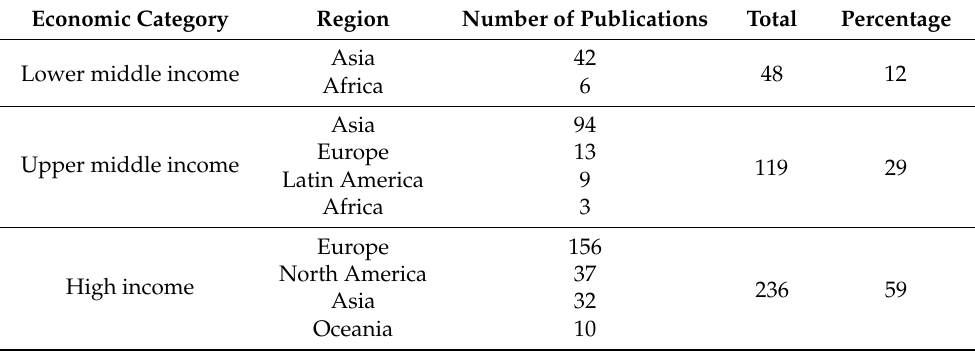
Table 3. Distribution of the 402 papers reviewed based on region of origin and economic category of country of origin.